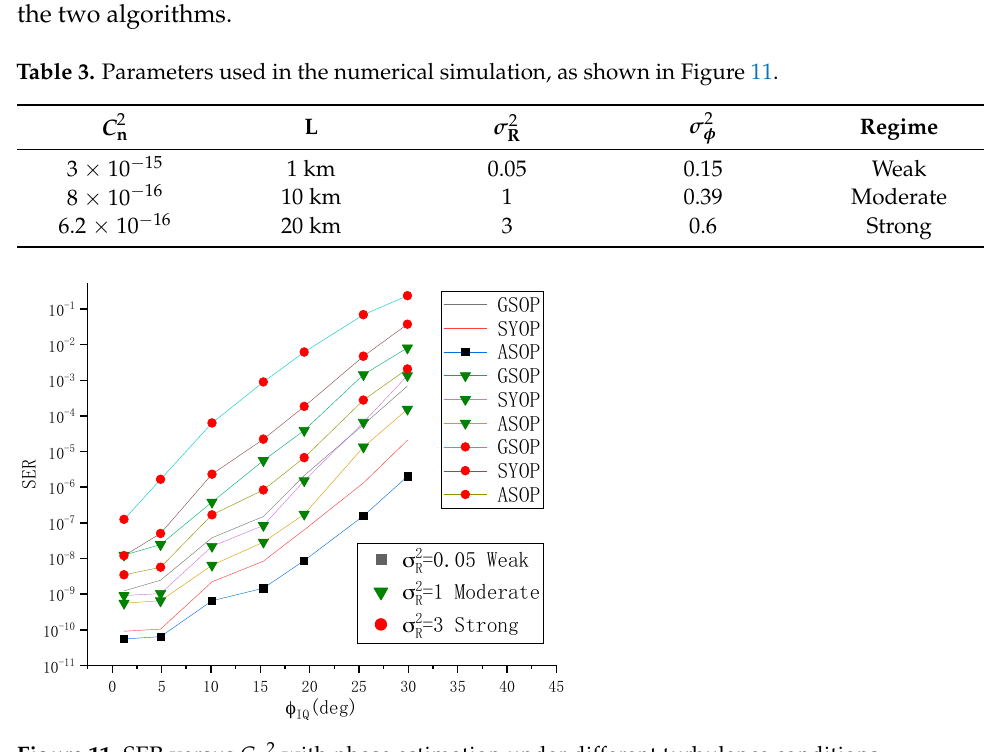
Figure 11. SER versus C n2 with phase estimation under different turbulence conditions.